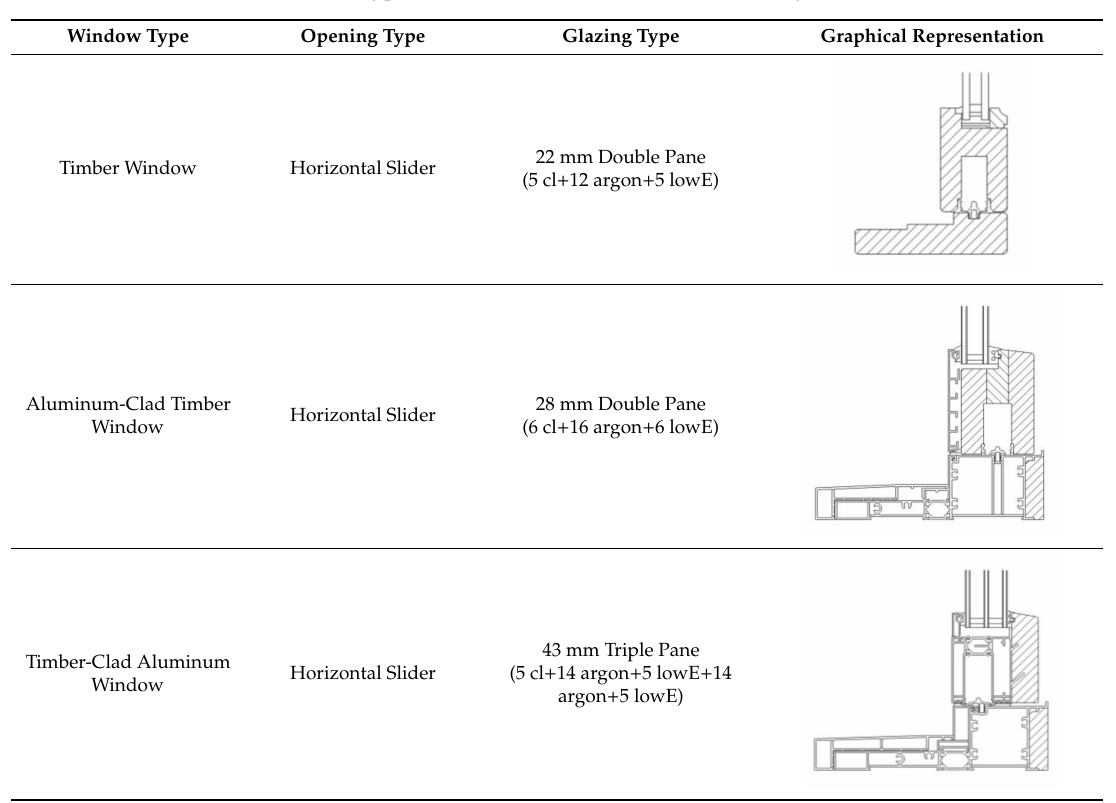
Table 1. Types of timber-based windows for the